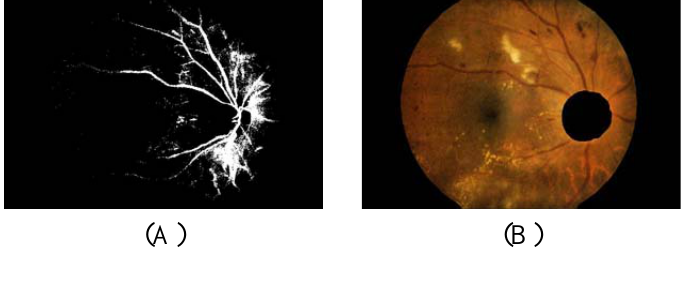
Figure 2. Blood vessel and optic disc detection. (A) Blood vessel detected from decorrelation stretch image. (B) Optic disc area eliminated from the contrast enhanced